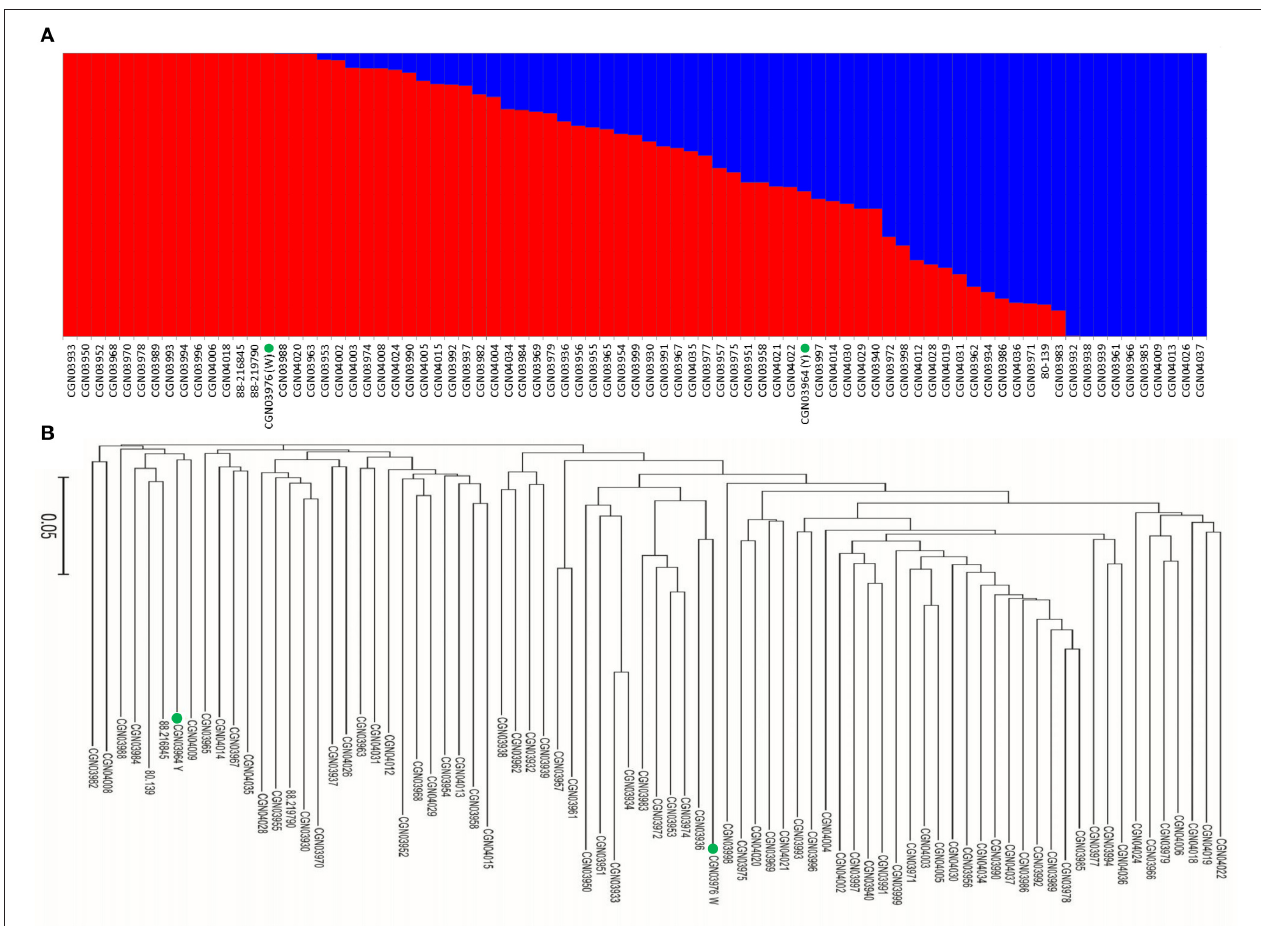
FIGURE 2 | Analysis of genetic diversity of 81 B. carinata accessions. (A) The population structure of 81 accessions of B. carinata . K = 2. Two colors represent two sub-populations. (B) The neighbor-joining phylogenetic tree of 81 accessions of B. carinata . The two parents of YW DH population; Y-BcDH64 and W-BcDH76 were coded in green